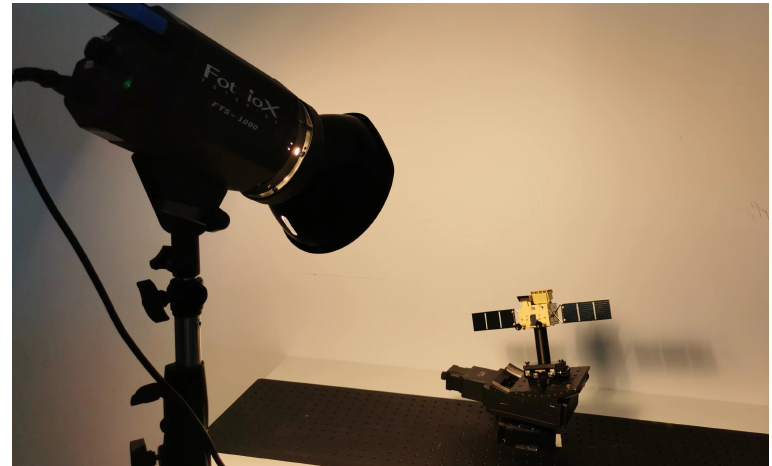
Figure 10. Laboratory measurement scene.